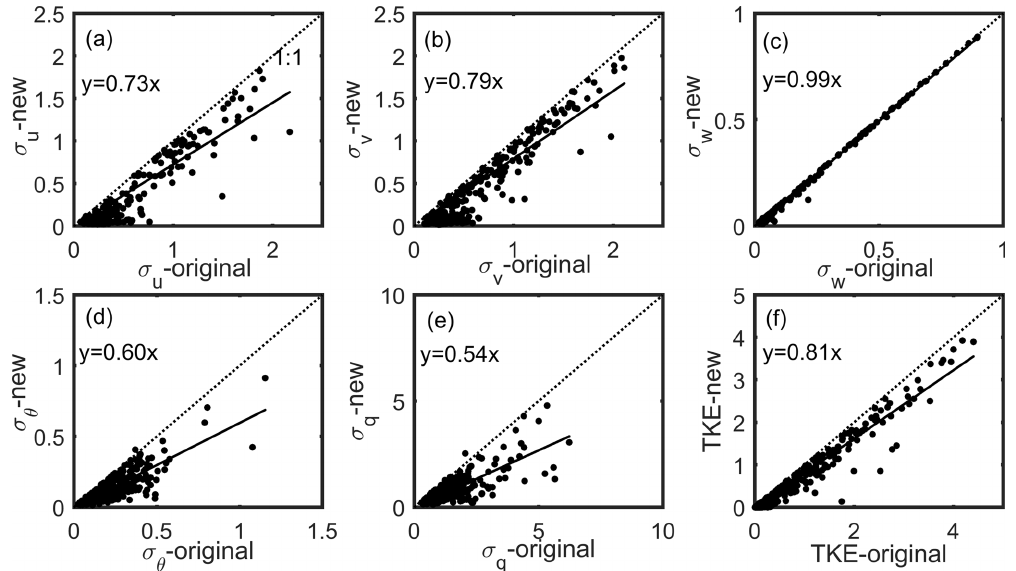
Figure 4. Comparison of σ u (a) , σ v (b) , σ w (c) , σ θ (d) , σ q (e) , and TKE (f) from the new half-hour results with those from the original results from 16 December 2016 to 8 January 2017 at the suburban site. The black dotted line represents the 1 : 1 line in the figures. The black solid line represents the fitted results.